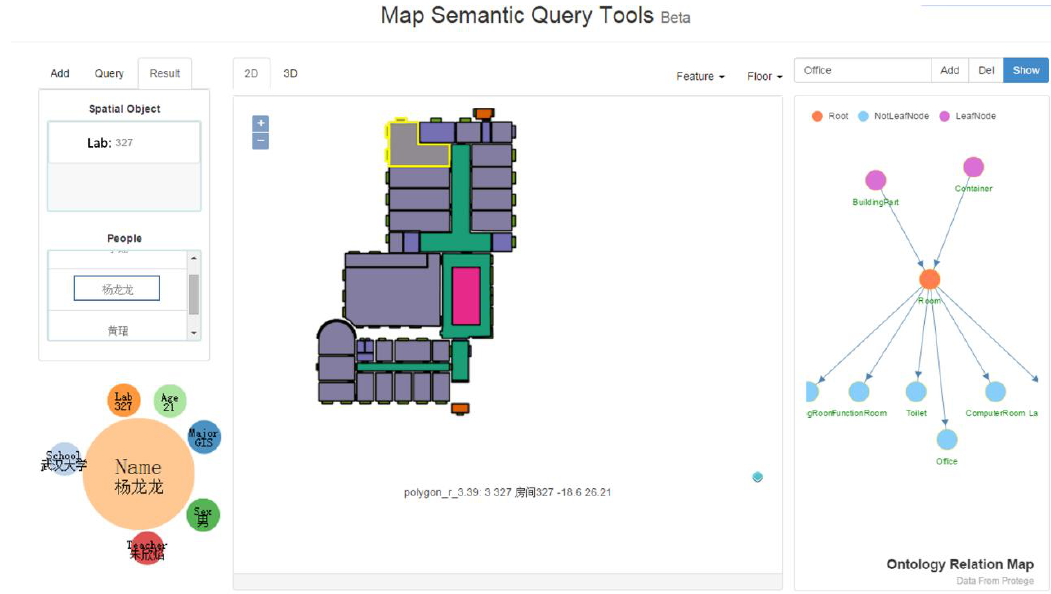
Figure 8. The Results of Example Query